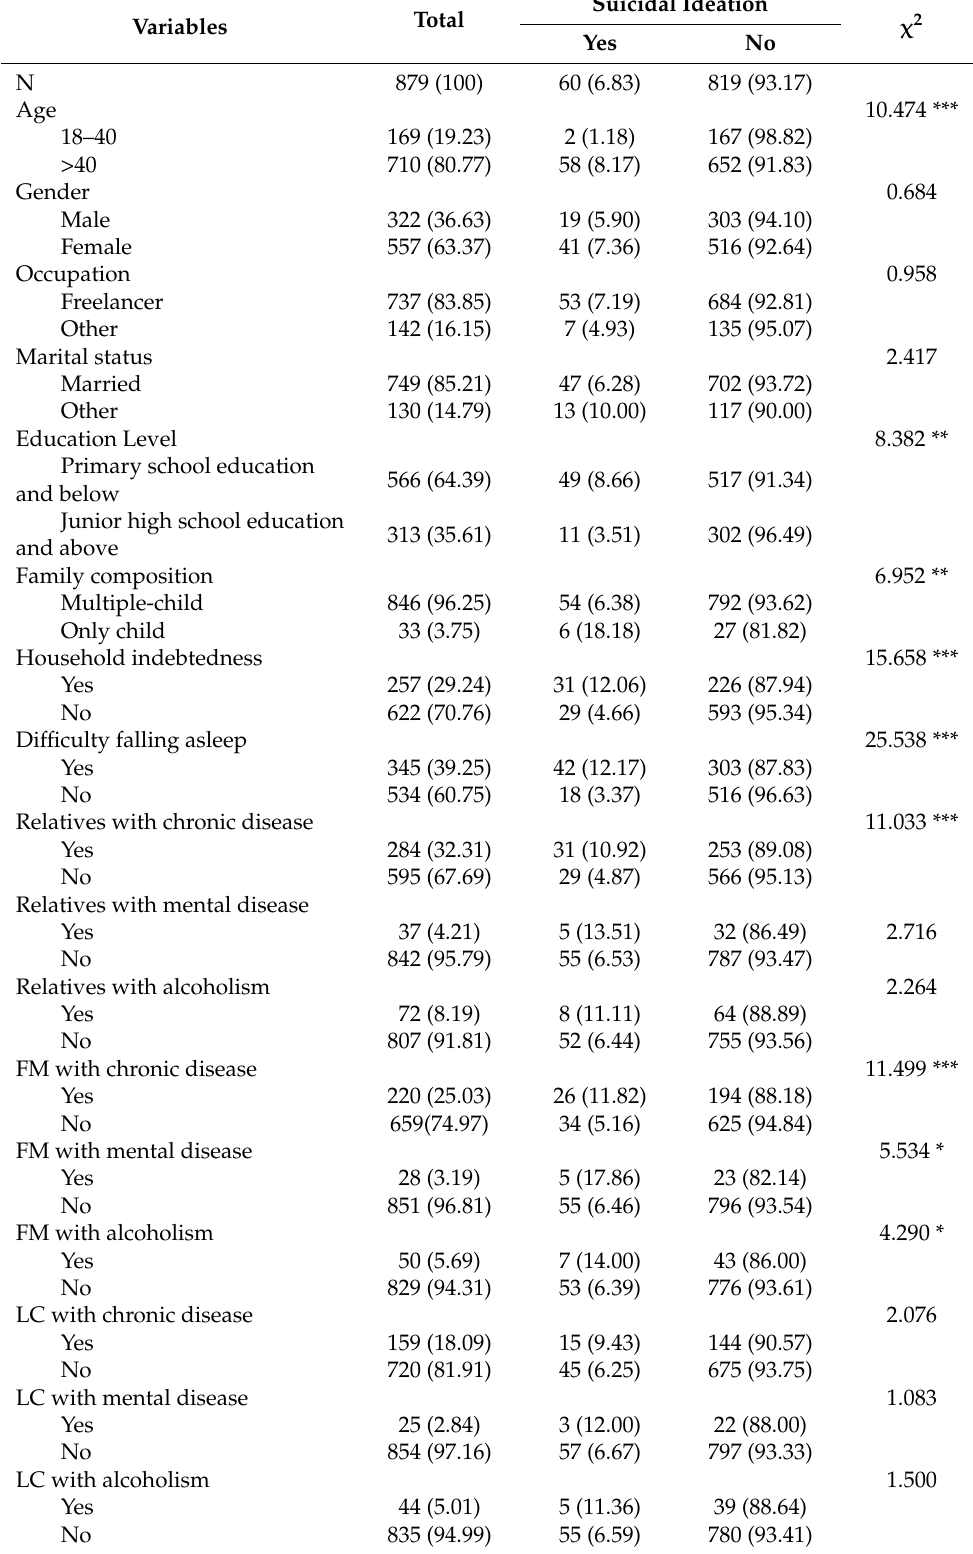
Table 1. Characteristics and univariate analysis of suicidal ideation among the